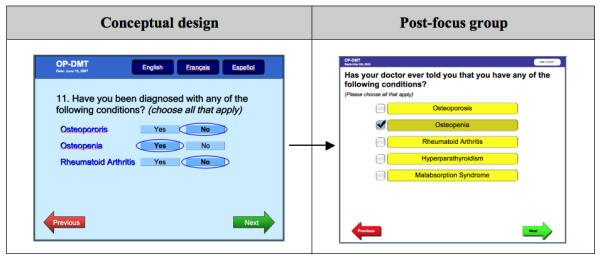
RAQ question about medications.